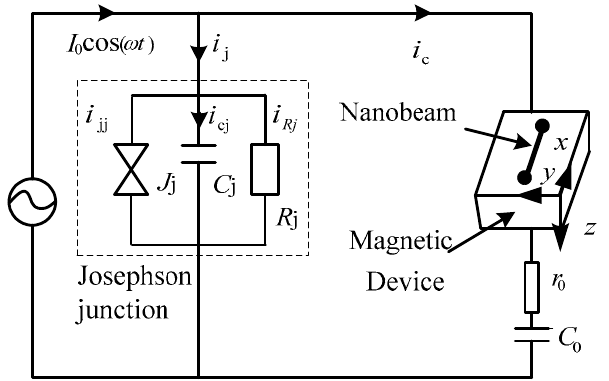
Figure 1. Schematic circuit of NEMS with Josephson